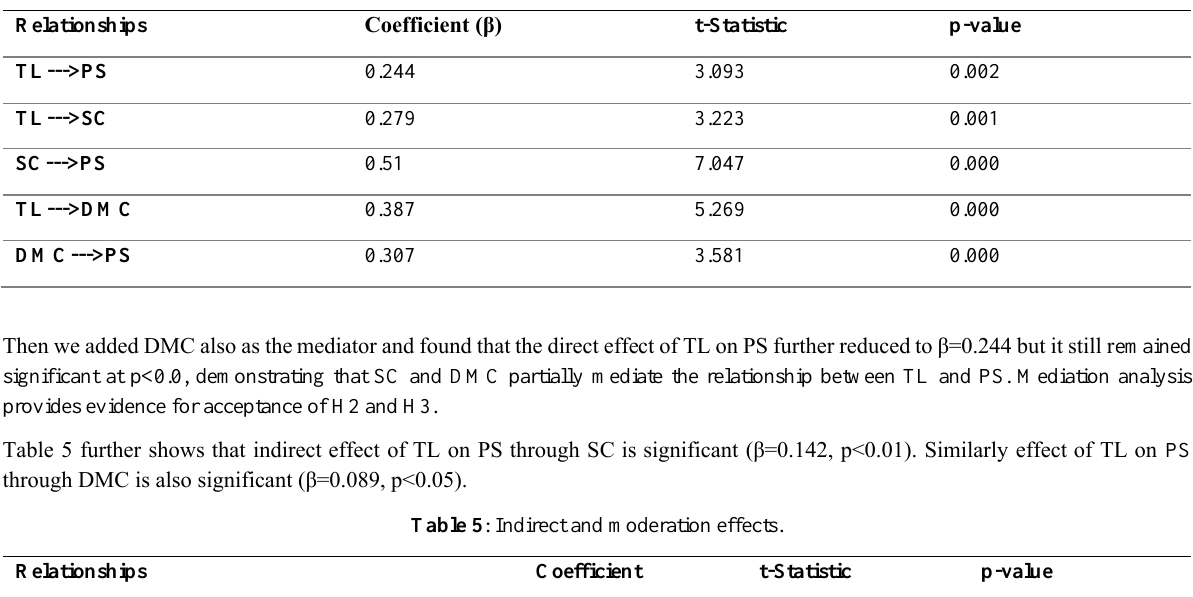
Table 4: Analysis of structural model